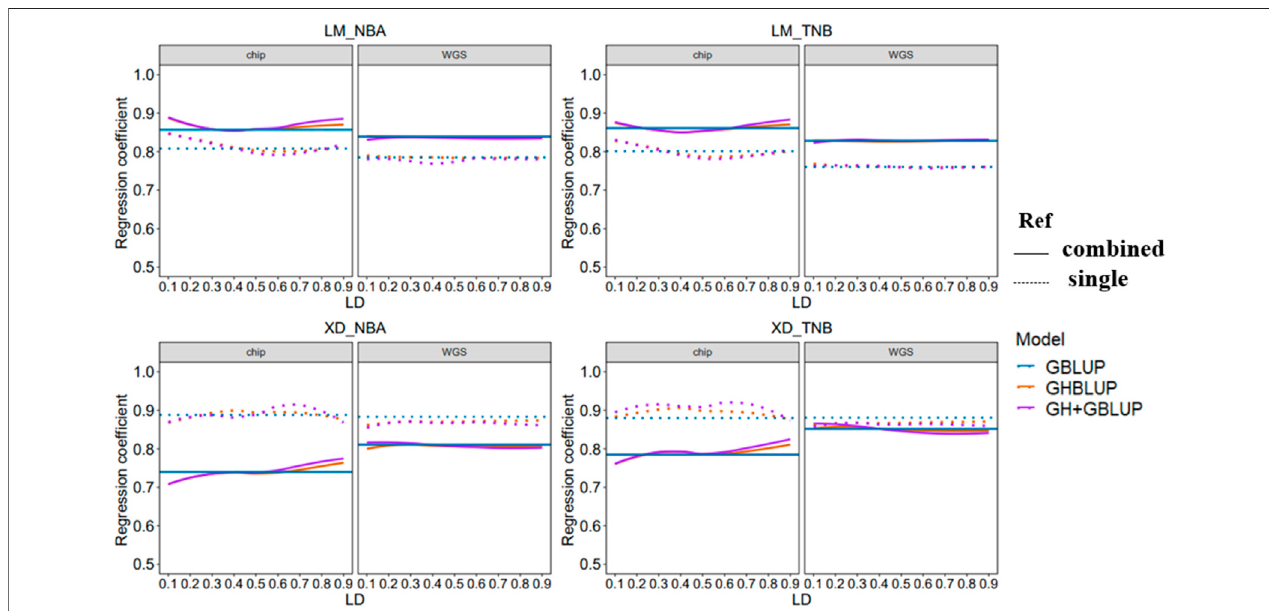
FIGURE4| Regressioncoef fi cientofallscenarioswithdifferent r 2 thresholds.Theleftsideshowsthetrendofaccuracypredictedusingthe80 Kchipdatawhilethe right sideusingthe WGSdata.The differentcoloredlines representdifferentprediction methods inwhich blue, orange,and purple linerepresentGBLUP,GHBLUP, and GH + GBLUP, respectively. The solid line represents the prediction accuracy trend of combined population, while the dotted line represents the single population.